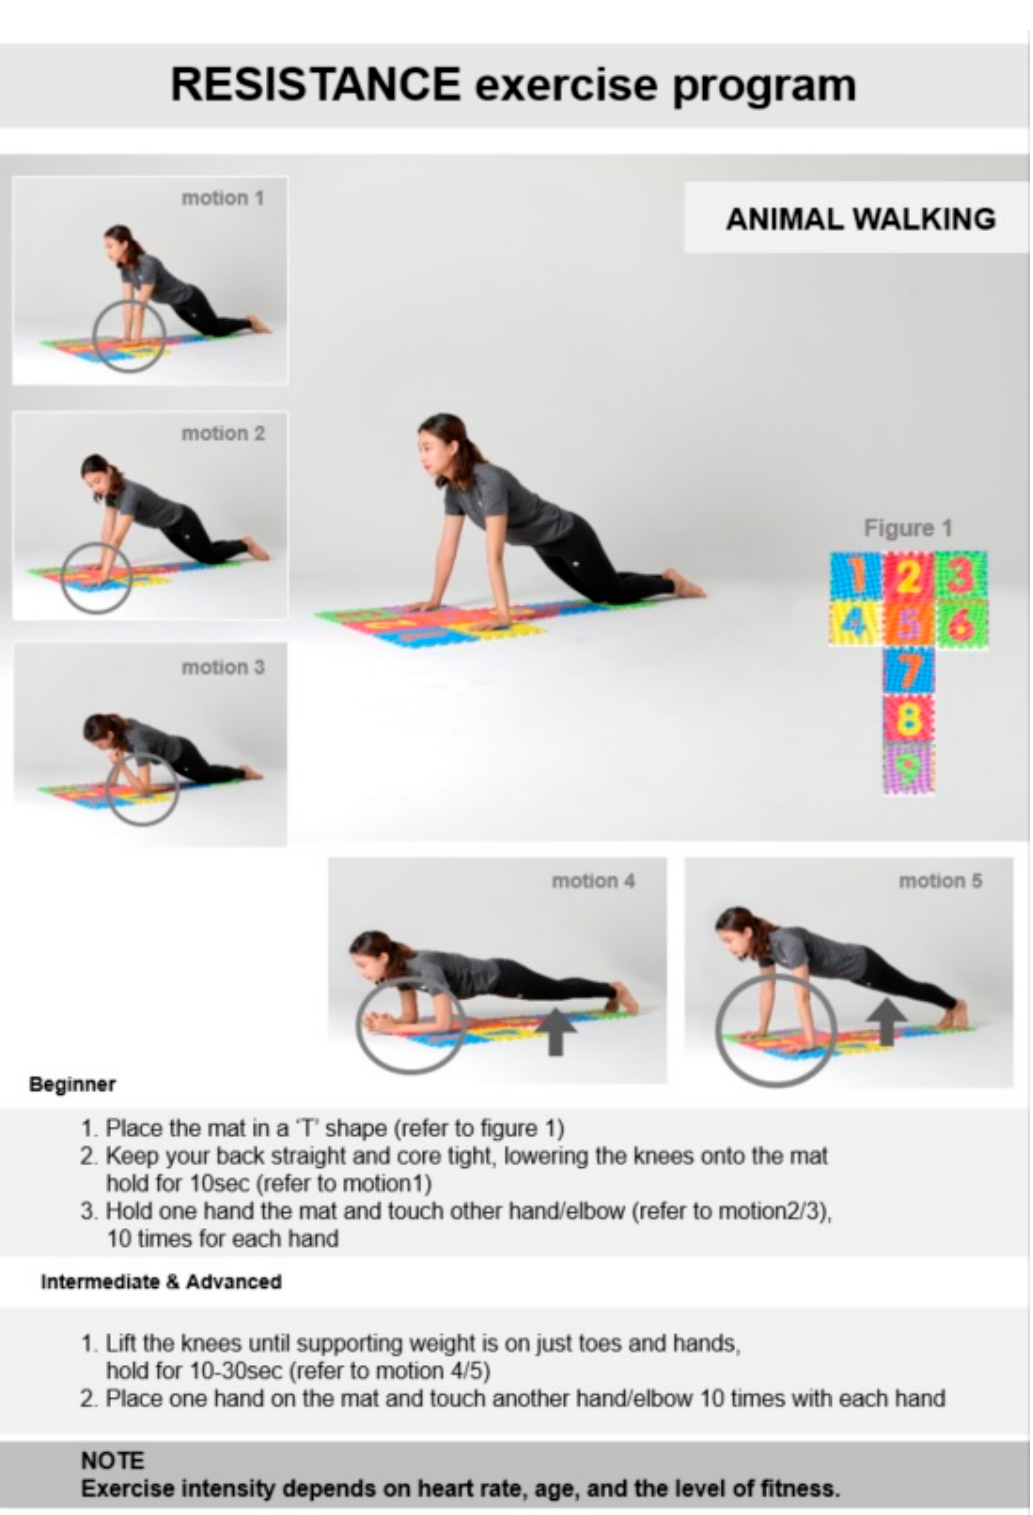
Figure A15. Detailed description and components of each movement in the “Animal walking” resistance exercise.